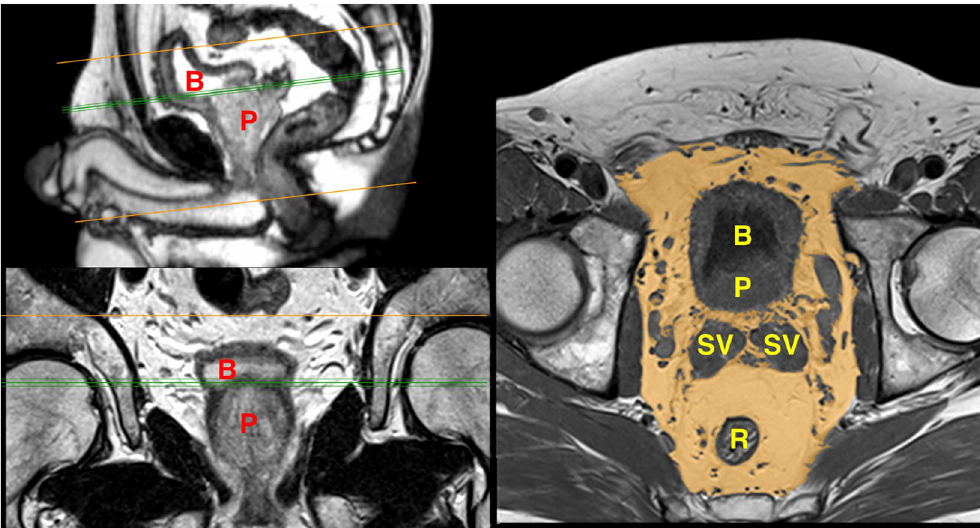
Figure 2. Sagittal and coronal images were used to identify the first slice at the level of the base of the prostate represented by the green lines. The yellow area represents the periprostatic fat, which was segmented from multiple sequential slices starting from this level to the prostate apex. P = Prostate gland; B = Bladder; R = Rectum; SV = Seminal Vesicle.